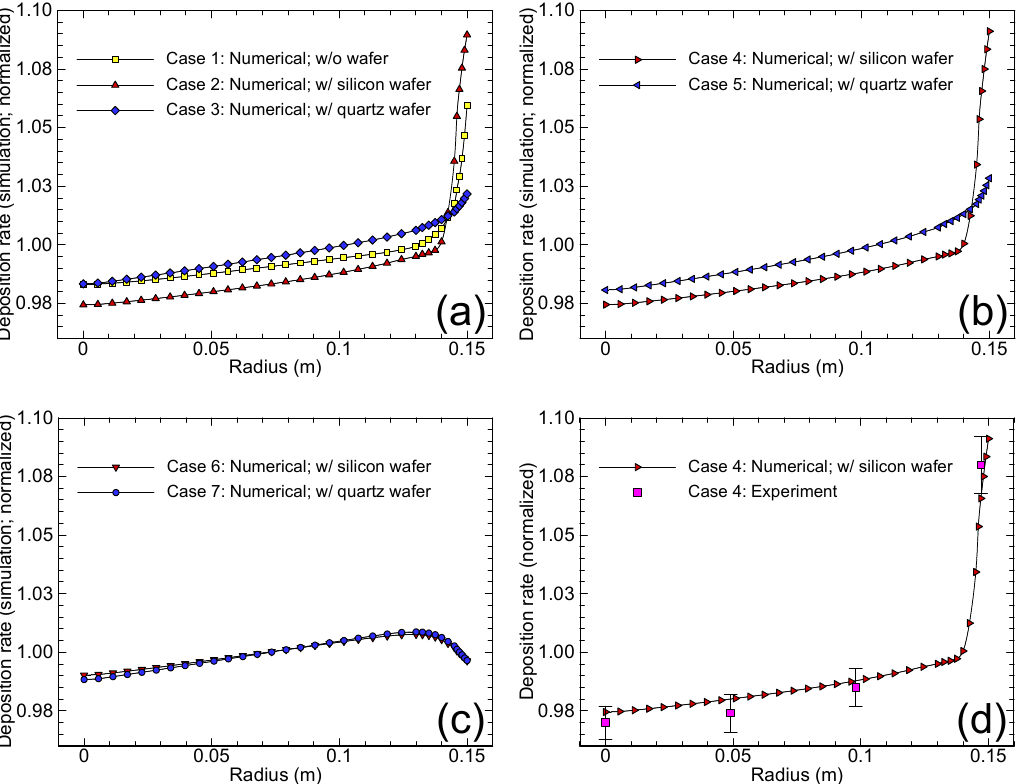
Figure 7. Effect of the dielectric components on the deposition rates. Deposition rate profiles for ( a ) Case 1, Case 2, and Case 3; ( b ) Case 4 and Case 5; ( c ) Case 6 and Case 7. ( d ) Experimental data of Case 4 superimposed on the profile of Case 4. The profiles are normalized with their corresponding averaged values.